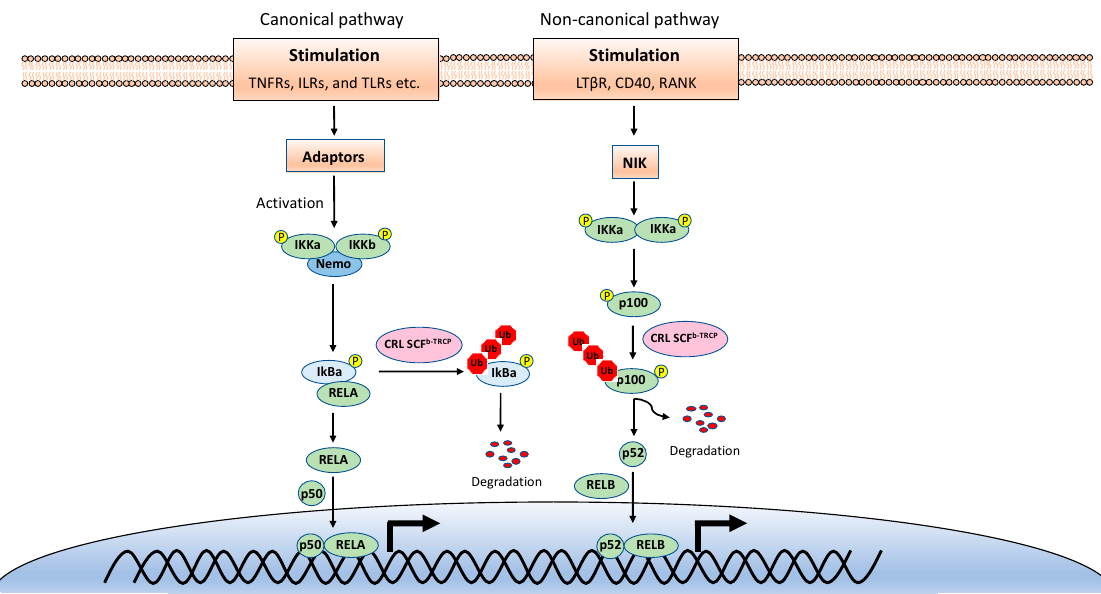
Figure 1. The canonical and noncanonical nuclear factor κ B (NF- κ B) pathways.